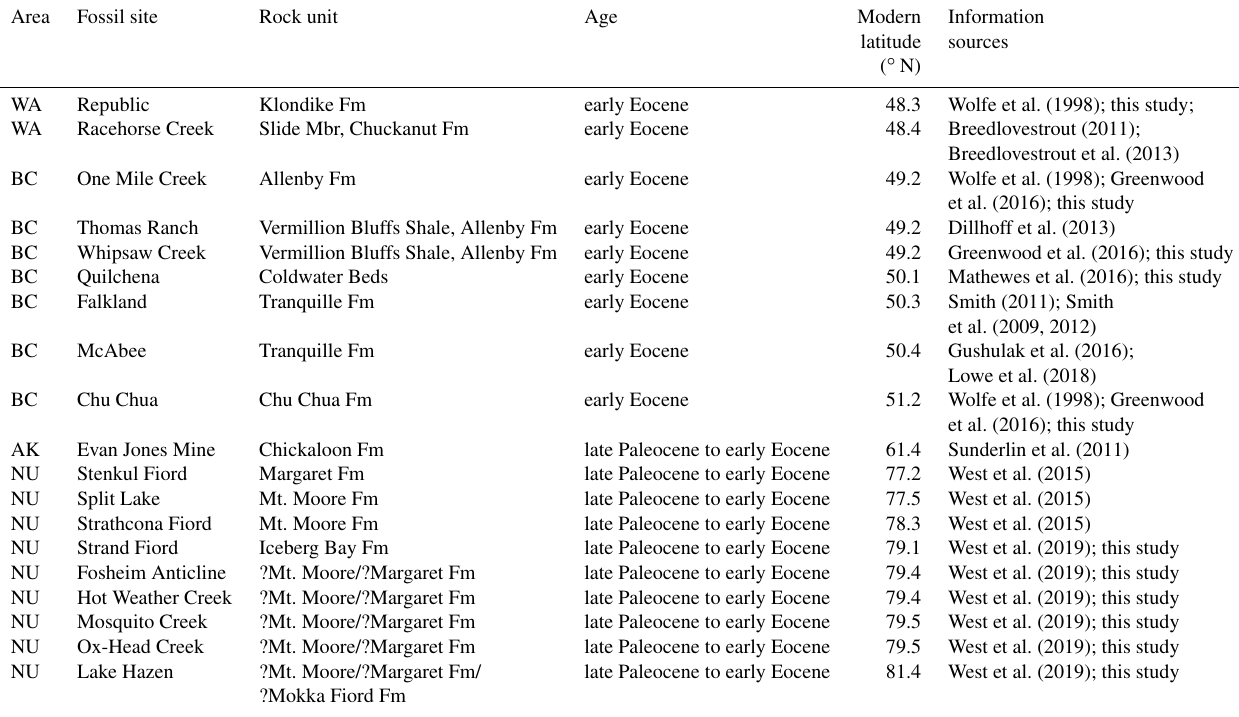
Table 1. Locality information for fossil sites discussed in this study. BC – British Columbia, Canada; NU – Nunavut, Canada; WA – Washington, USA; AK – Alaska,